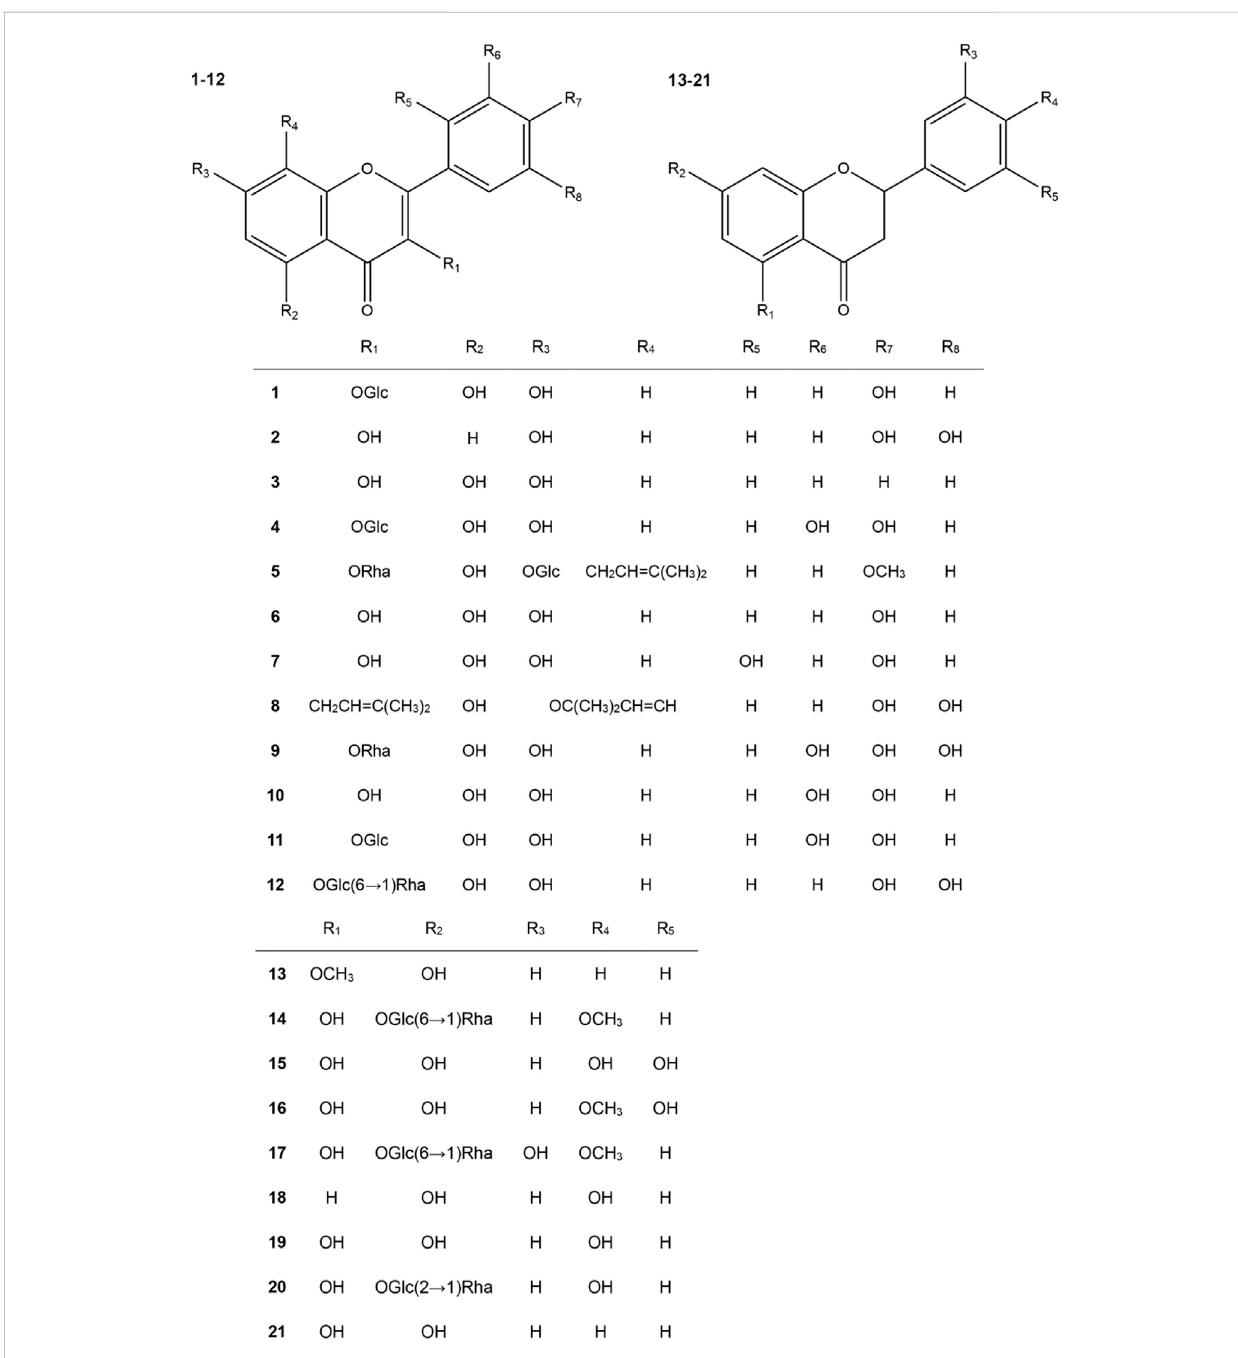
Structural formulas of natural fl avonols and fl avanones for the treatment of